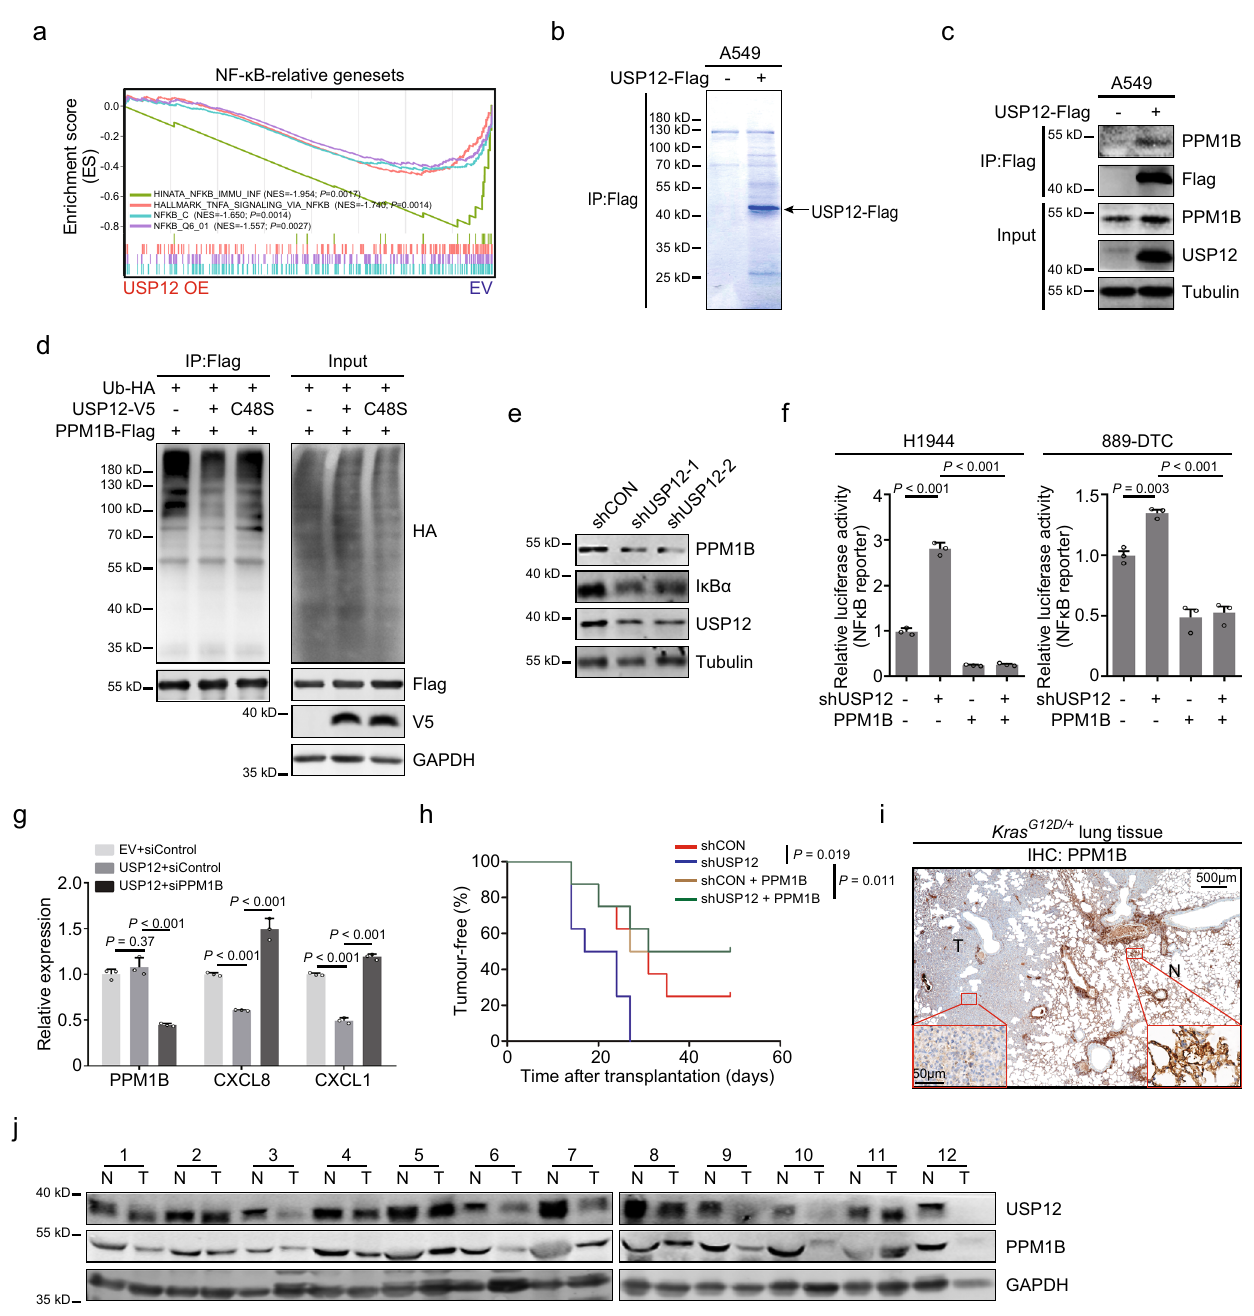
Fig. 4 USP12 deubiquitinates and stabilizes PPM1B. a GSEA of the transcriptional pro fi les of USP12-overexpressed (OE) A549 cells and control cells (EV) with the NF- κ B-related signatures. b The immunoprecipitates (IP) captured by an anti-Flag antibody from indicated cells were separated by SDS-PAGE gel and analysed by mass spectrometry. c Cell lysates with or without USP12-Flag were immunoprecipitated, and endogenous PPM1B was examined by immunoblotting. d PPM1B-Flag and ubiquitin-HA were co-expressed with wide type (WT) USP12 or the catalytically inactive mutant (C48S) in 293T cells. PPM1B was subjected to IP, and the polyubiquitination of PPM1B was assessed by immunoblotting using an anti-HA antibody. e 889-DTC cells with USP12 silencing (shUSP12) were immunoblotted with indicated antibodies. f The relative luciferase activities were analysed in the indicated cells (mean ± SEM, n = 3 per group). One-way ANOVA followed by Tukey ’ s HSD test. g Quanti fi cation of PPM1B, CXCL1 and CXCL8 mRNA levels in indicated H358 cells (mean ± SEM, n = 3 per group). One-way ANOVA followed by Tukey ’ s HSD test. h Kaplan-Meier plots showing the tumour-free period after transplantation with indicated 889-S1 cells ( n = 8 per group). Two-sided log-rank test. i Representative IHC staining of PPM1B in lung tissues from Kras G12D/ + mice. Representative images are from three biologically independent mice. j Protein levels of USP12 and PPM1B in human NSCLC